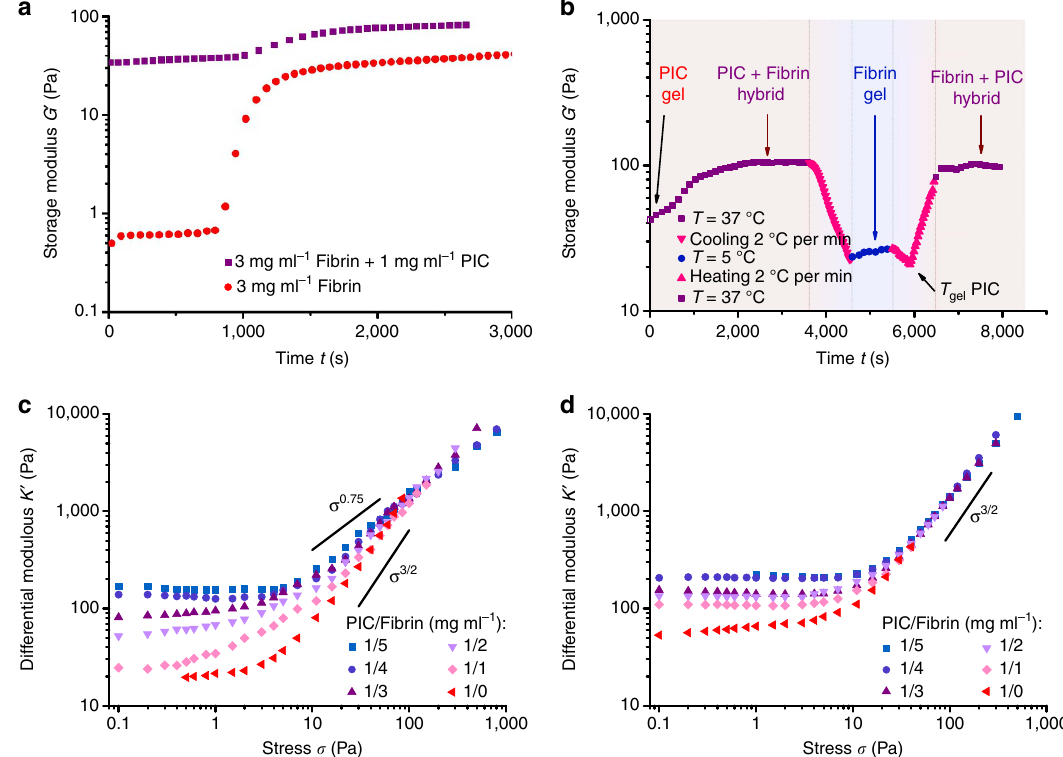
Figure 3 | Mechanical properties of composites with semi-flexible PIC networks and semi-flexible fibrin networks. ( a ) Time trace of the storage modulus G 0 , showing the formation of the fibrin network in the presence of the PIC network (black squares) and without the PIC network (red dots) at T ¼ 37 (cid:2) C. In the composite, the starting modulus at t ¼ 0s is much higher, because the PIC hydrogel is formed already. ( b ) Time trace of G 0 of the composite PIC (1mgml (cid:2) 1 )/fibrin (3mgml (cid:2) 1 ) hydrogel through a cooling and heating cycle. At t ¼ 0, only the PIC network is present; at t E 3,000s, G 0 has PIC and fibrin contributions; cooling shows G 0 of fibrin only and reheating restores the modulus completely. ( c ) Differential modulus K 0 as a function of stress s for PIC/fibrin interpenetrating networks with varying PIC to fibrin mass ratios, showing different stiffening responses. The solid lines represent the stiffening responses K 0 p s m with m ¼ 0.75 for fibrin and m ¼ 3/2 for PIC. ( d ) Conjugated PIC/fibrin hybrid hydrogels with AKQAGDV peptide- functionalized PICs (0.2%) all show a similar stiffening response, with K 0 p s 3/2 .